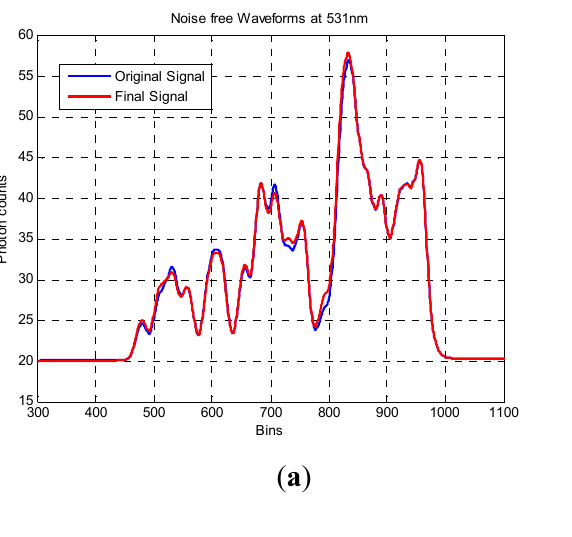
concentrations against the true values. The root mean square error is of the recovered C ab 1.96 ug·cm − 2